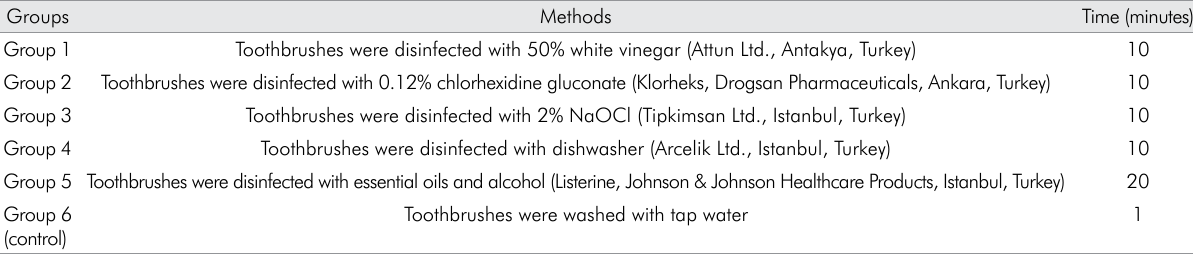
Table 1. The methods of disinfection examined in this study.